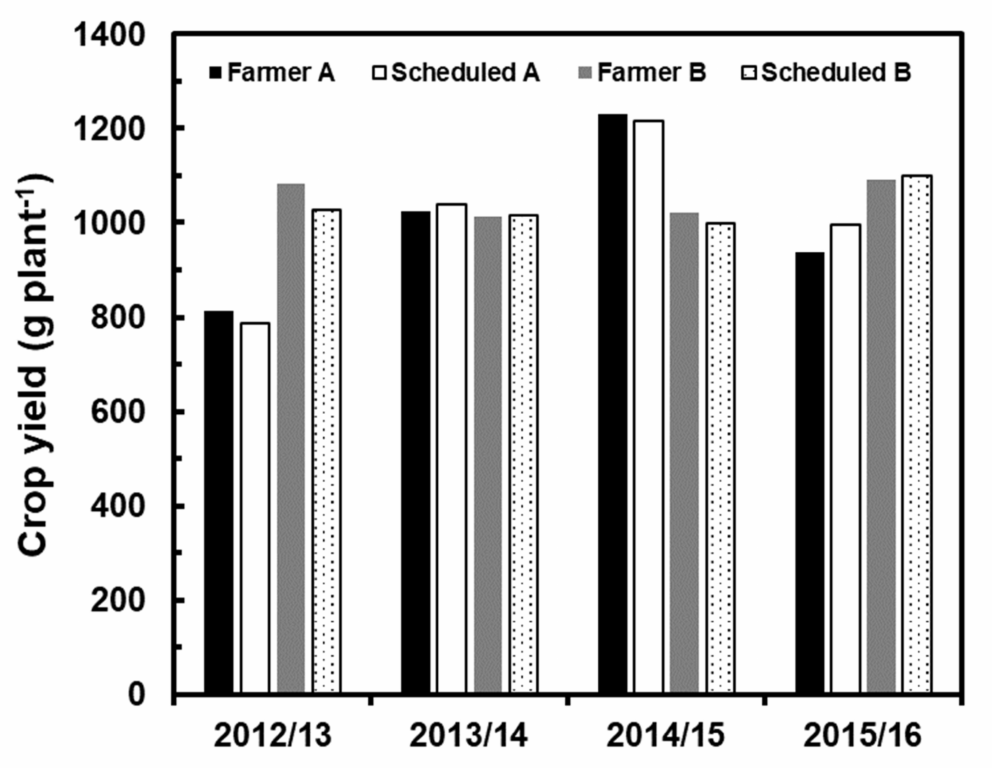
Figure 10. Crop yield by Farmer A, Farmer B, and irrigation scheduled by IFAPA in both